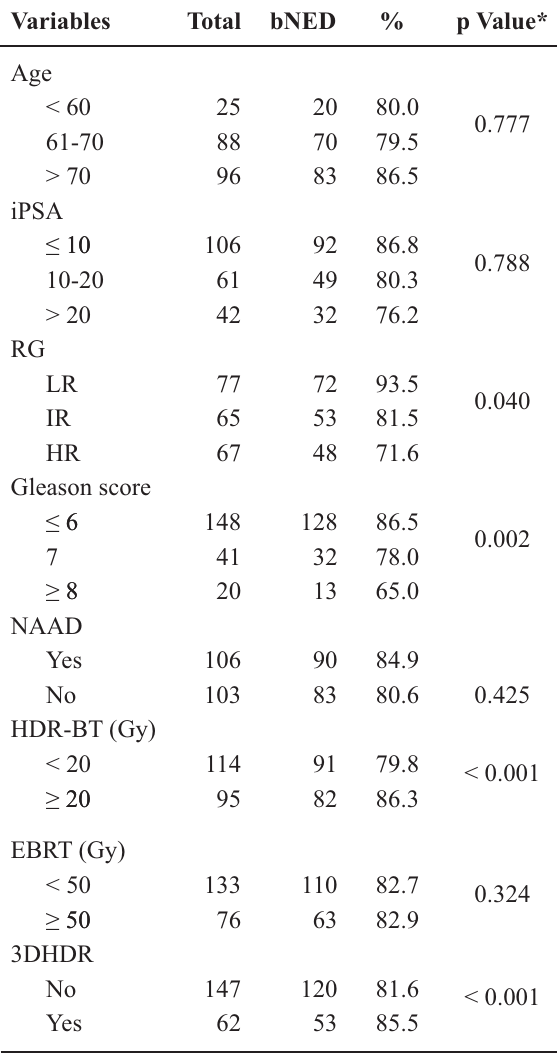
Table 2 – Univariate